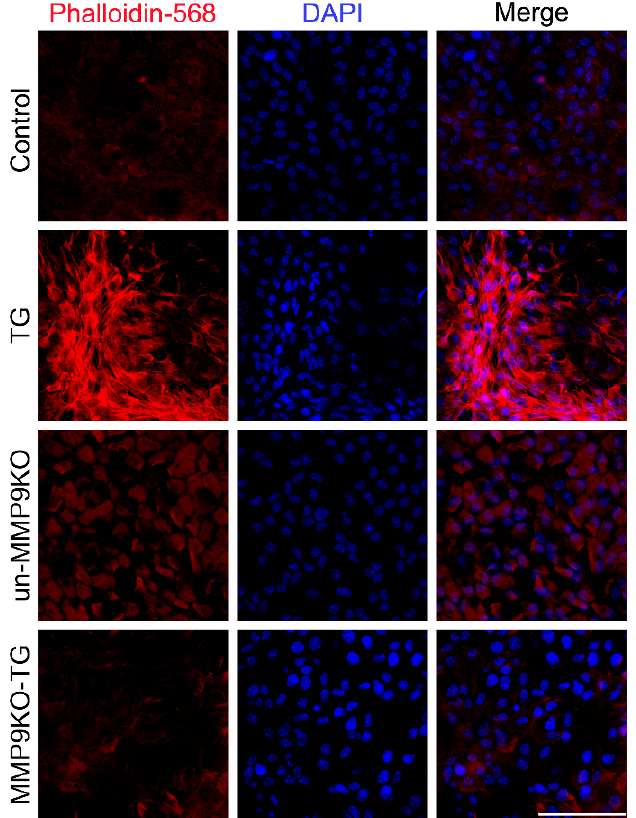
Figure 1. F-actin polymerization upon TGF- β stimulation. LEC explants from wildtype mice were left untreated (control) or treated with 500 pg/mL TGF- β for 72 h (TG). LEC explants from MMP9KO mice were left untreated (un-MMP9KO) or treated with 500 pg/mL TGF- β for 72 h (MMP9KO-TG) ( n = 3 independent experiments, where n ≥ 3 LECs per treatment were used for each experiment). Paraformaldehyde (PFA) fixed explants were stained for F-actin using phalloidin-568. Images were acquired using Leica DM6 fluorescence microscope at 40×. Scale bar, 100 µm.